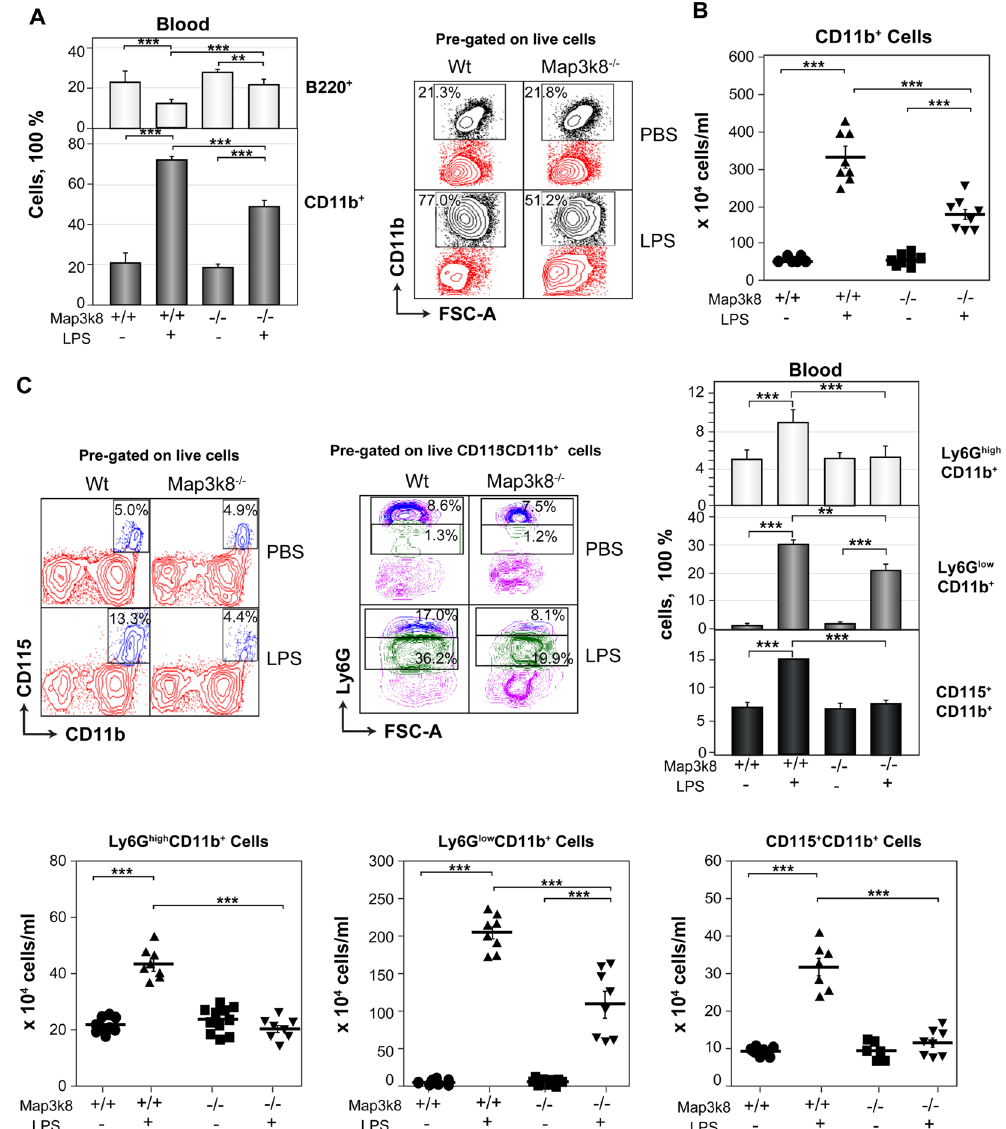
Figure 1. Map3k8 deficiency decreases circulating myeloid cells in LPS-induced emergency haematopoiesis. Wt and Map3k8 − / − mice received two i.p. injections of LPS or PBS; 24 h after the last injection, the blood levels of B220 + B and CD11b + myeloid cells, Ly6G high CD11b + mature and Ly6G low CD11b + immature neutrophils, and CD115 + CD11b + monocytes were analysed by flow cytometry. ( A ) The left panel shows the frequency of B220 + B and CD11b + myeloid cells relative to the total number of circulating cells. The right panel shows a representative dot plot depicting circulating CD11b + myeloid cells. ( B ) Number of circulating CD11b + myeloid cells in the different groups. ( C ) Representative dot plots showing the percentage of circulating CD115 + CD11b + monocytes and of Ly6G high CD11b + mature and Ly6G low CD11b + immature neutrophils relative to the total number of circulating cells. The right panel shows the percentages of these cells relative to total circulating cells in blood, and the numbers are provided in the lower panel. ( A – C ) Mean ± SEM ( n = 8). Newman-Keuls tests were performed to analyse significant differences among groups. * p < 0.05, ** p < 0.01, *** p <